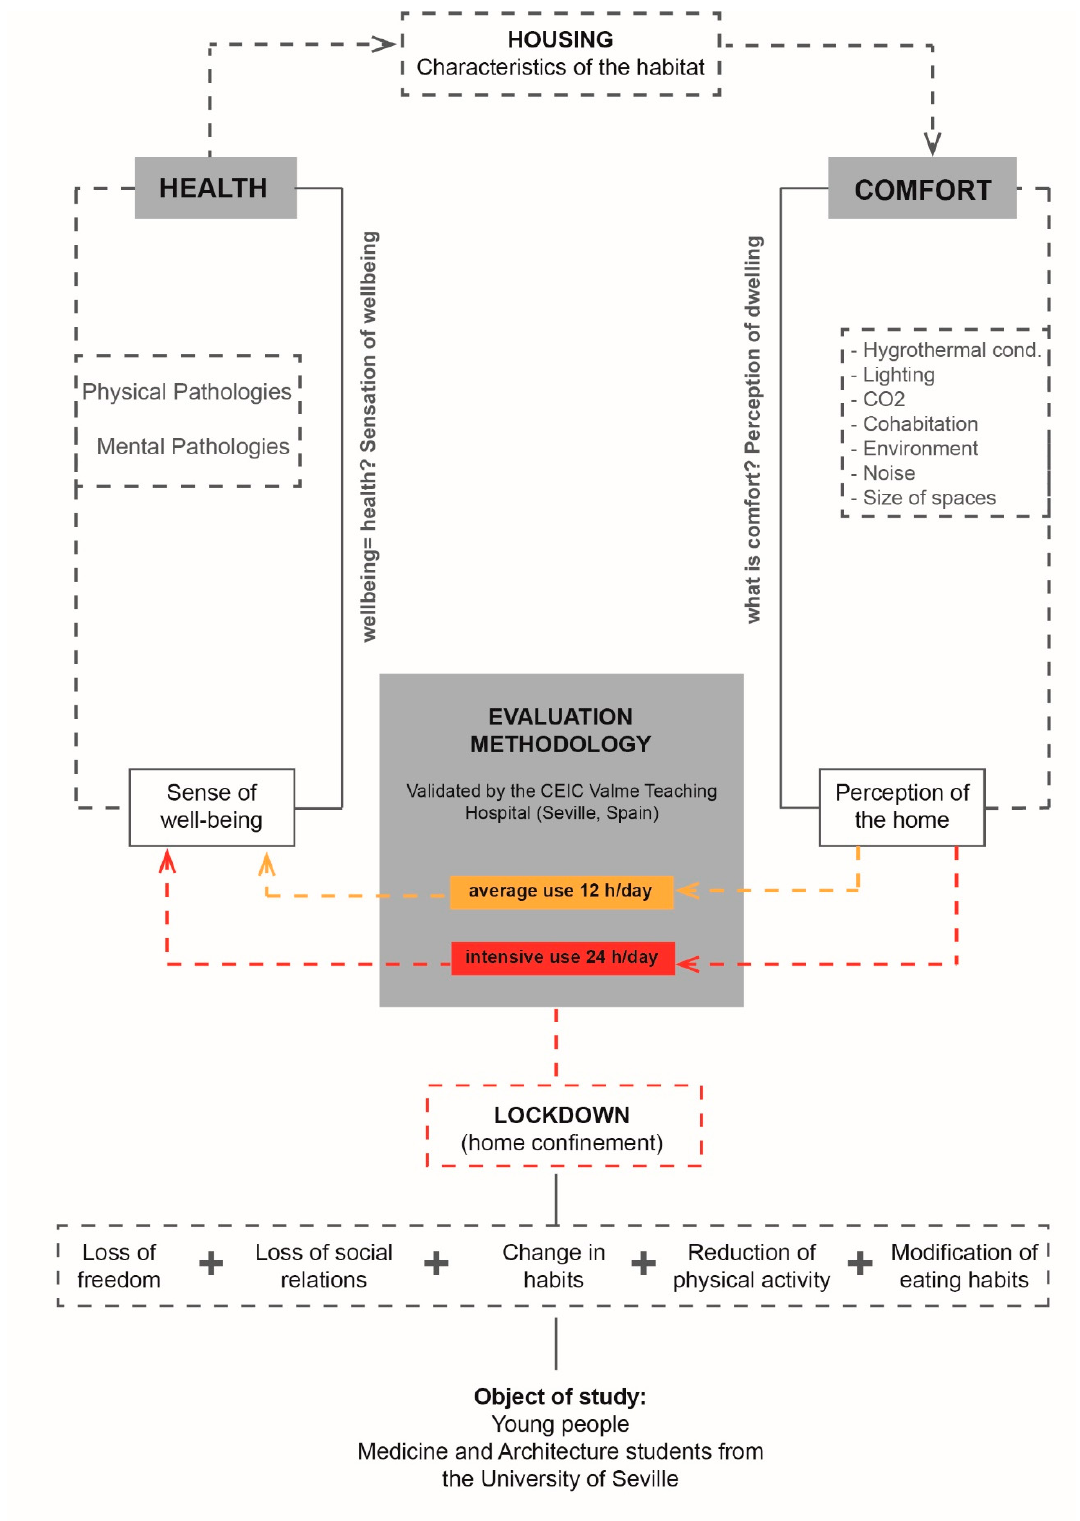
Figure 1. Diagram of the analysis carried out. Quantitative variables were summarised with means and standard deviations and qualitative variables with percentages. Qualitative variables were analysed using the chi- square test and Fisher’s exact test. Confidence intervals at 95% were obtained to